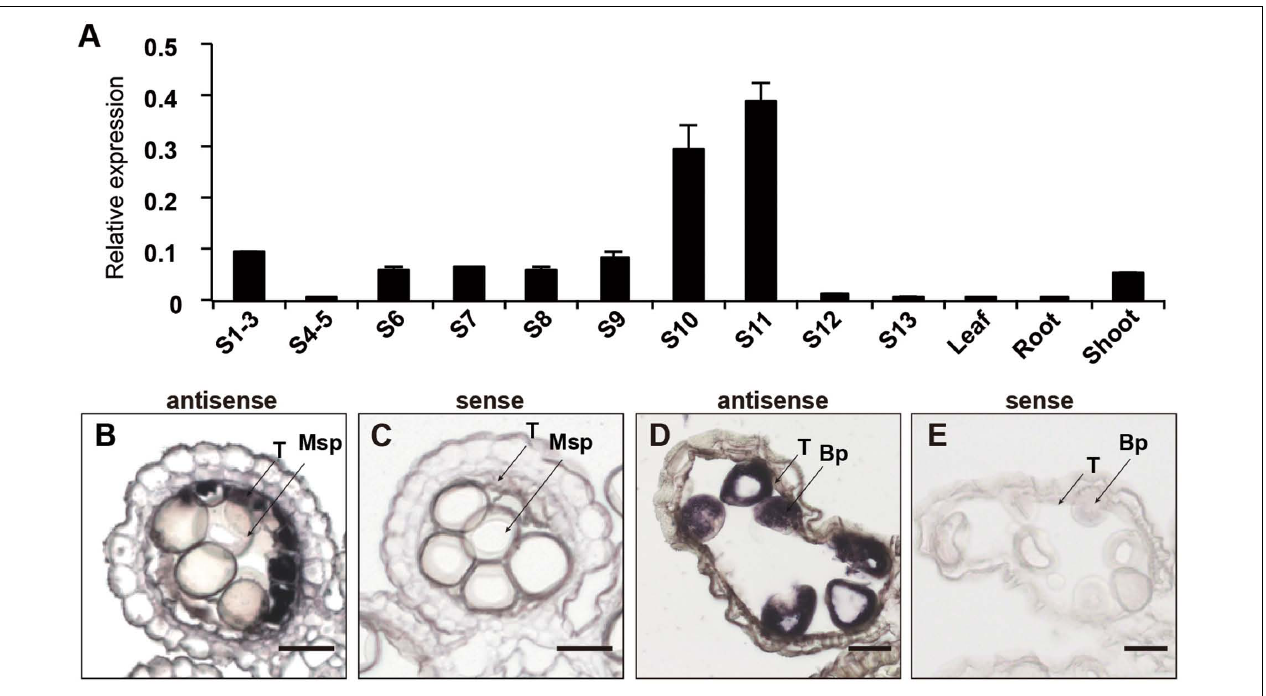
FIGURE 2 | The expression patterns of OsCER1 . (A) Spatial and temporal expression analysis of OsCER1 in spikelets at various anther developmental stages by qRT-PCR. S1-3, before stage 3; S4-5, from stages 4 to 5; S6, stage 6; S7, stage 7; S8, stage 8; S9, stage 9; S10, stage 10; S11, stage 11; S12, stage12; S13 stage13. OsActin1 was used as an internal control. Each reaction had three biological repeats and error bars indicate the standard deviations (SD). (B–E) In situ hybridization of OsCER1 in WT anthers. The anthers at stage 10 (B) and stage 11 (D) hybridized with an OsCER1 antisense probe. The anthers at stage 10 (C) and stage 11 (E) hybridized with an OsCER1 sense probe. Bp, bicellular pollen; Msp, microspore; T, tapetum. Bars = 50 µ m in (B–E)